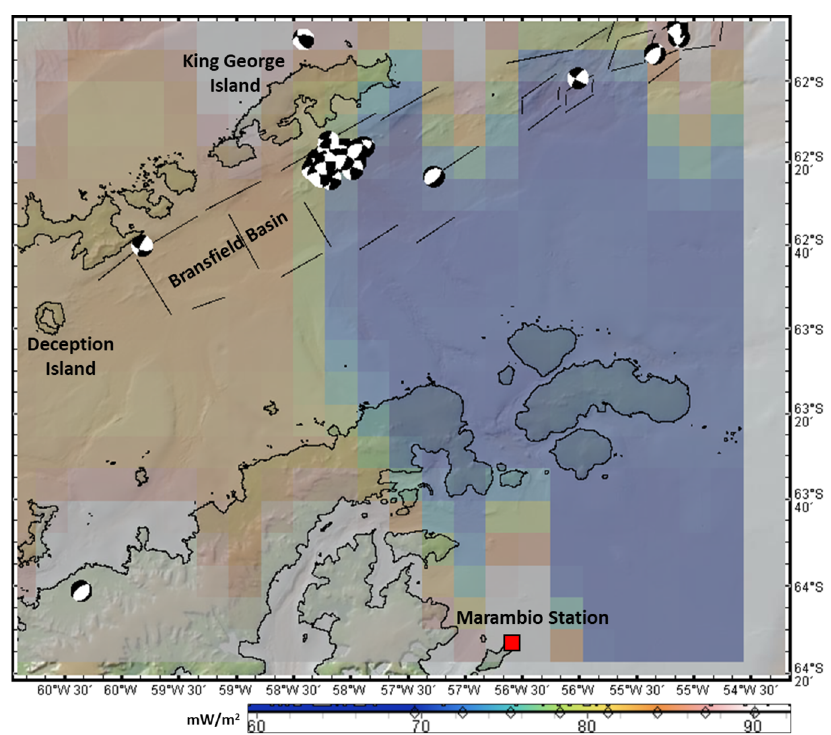
Figure 5. Antarctic Peninsula Map, including the archipelagos of the Shetland Plate (north of the Bransfield Basin). The beach balls represent focal mechanisms, and the green circles are some earthquakes with depths <50 km reported by the USGS. The free air anomalies [16] (upper map) define the geometry of the Bransfield Basin. The heat flow distribution [17] (lower map) in the area is <90 mW/m 2 . Suggested faults inside the basin were interpreted with swath bathymetry data [18]. The Marambio station (red square) represents the location of the MT monitoring. Figure made with GeoMapApp (www.geomapapp.org, accessed on 15 December 2022).